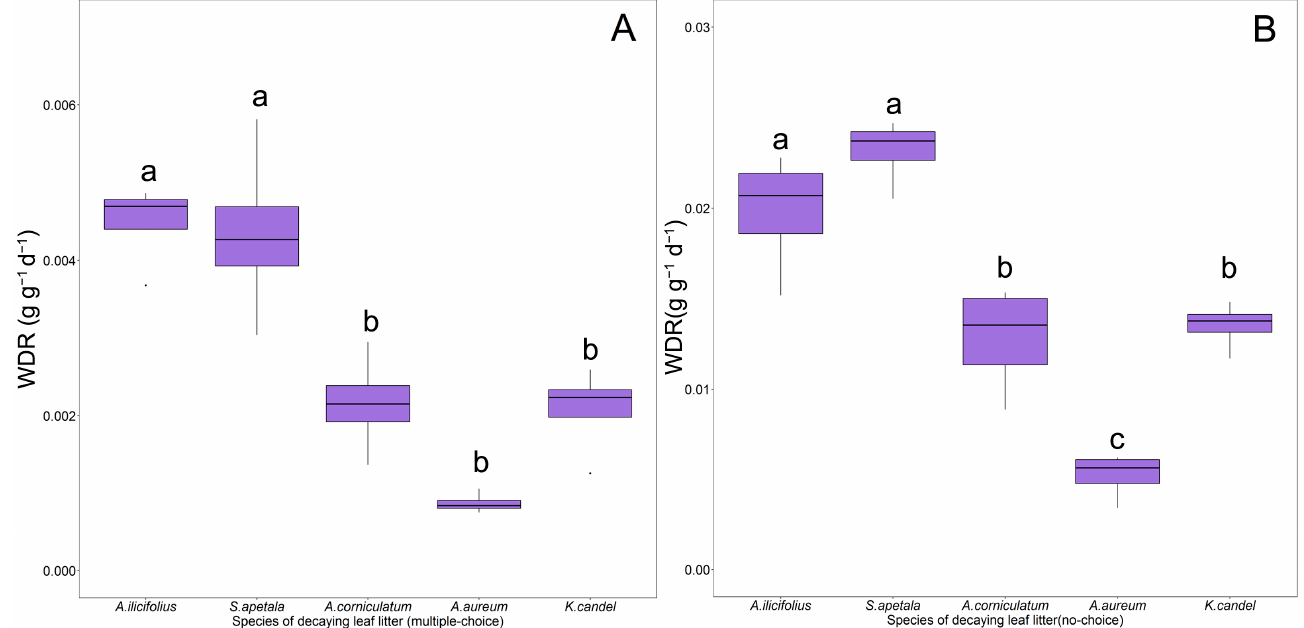
Figure 2. Boxplot of weight-specific daily feeding rate (WDR, g g − 1 d − 1 ) of P. canaliculata on decaying leaf litter of five mangroves under the multiple-choice condition ( A ) and the no-choice condition ( B ). Mangrove species includes A. ilicifolius ( Acanthus ilicifolius ), S. apetala ( Sonneratia apetala ), A. corniculatum ( Aegiceras corniculatum ), A. aureum ( Acrostichum aureum ), and K. candel ( Kandelia candel ). Species with the same letter are not significantly different (ANOVAs with Tukey or Kruskal–Wallis with Dunn–Bonferroni).